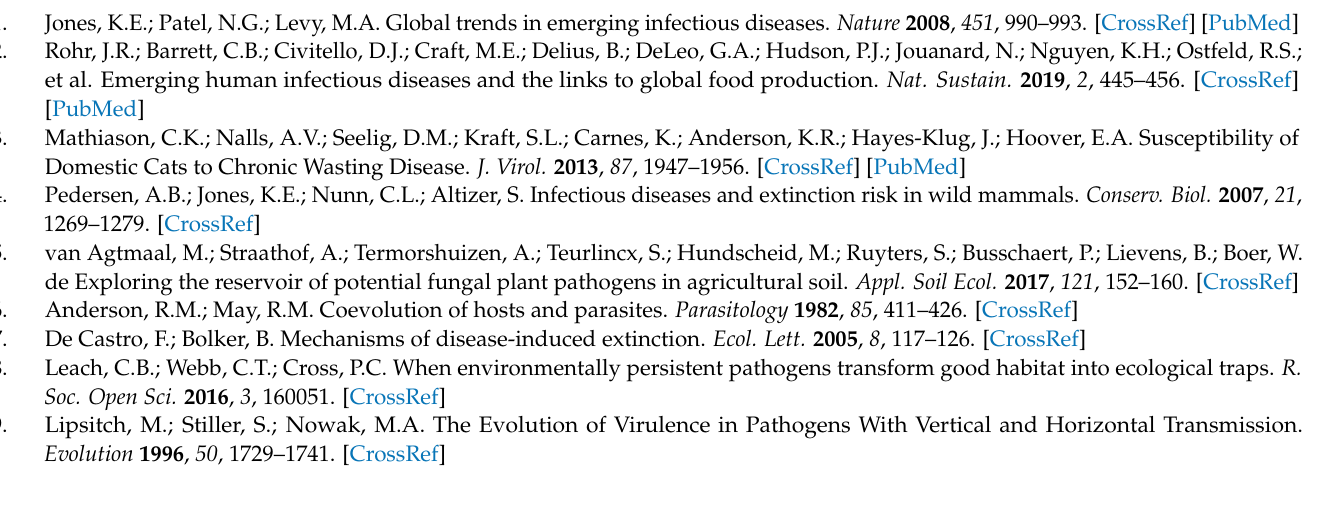
microcosms, Table S2: Results of soil abiotic parameter analysis and associated metadata, Table